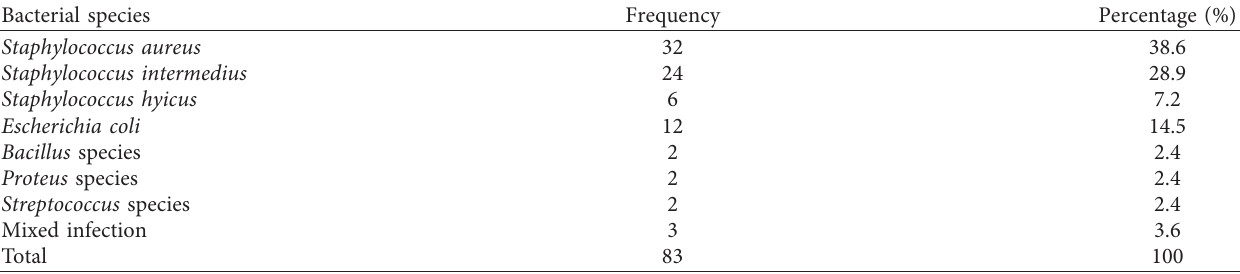
Table 1: Frequency and percentage of various bacterial species isolated from clinical mastitic samples ( n � 83) from Assela, Ethiopia.